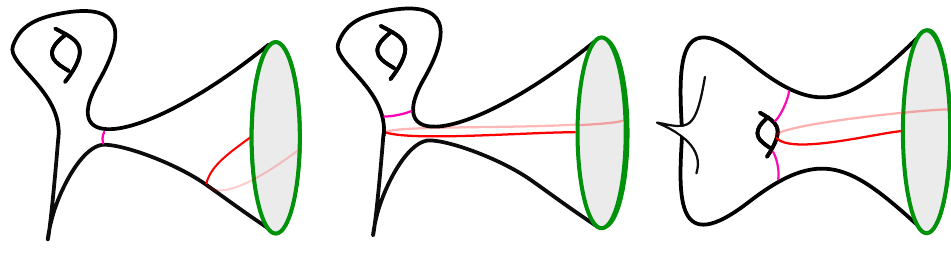
Figure 9 . An example (with genus 1 and 1 defect) of the type of hyperbolic surfaces which the path integral with defect insertions sums over. Once again, while there are an infinite number of non-self-intersecting boundary-to-boundary geodesics on such surfaces, above we have drawn an example of all possible surface topology that can result by cutting a genus 1 and 1 defect surface along the geodesics. Once again, the purple curves represent the closed geodesics which we use to glue the trumpet wavefunctions in (3.7) to different bordered Riemann surfaces. Compared to our computation in section 3, in the center figure we encounter a new ingredient as the decomposition of the manifold includes a “defect